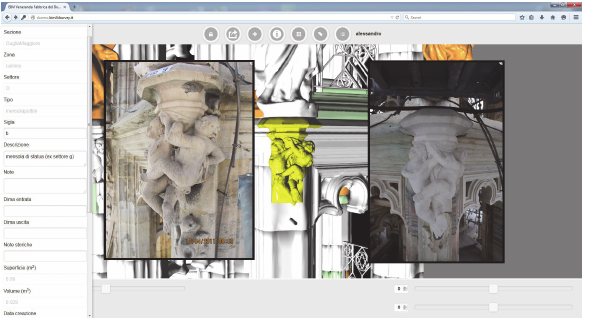
Figure 5. BIM3DSG multimedia gallery at work.